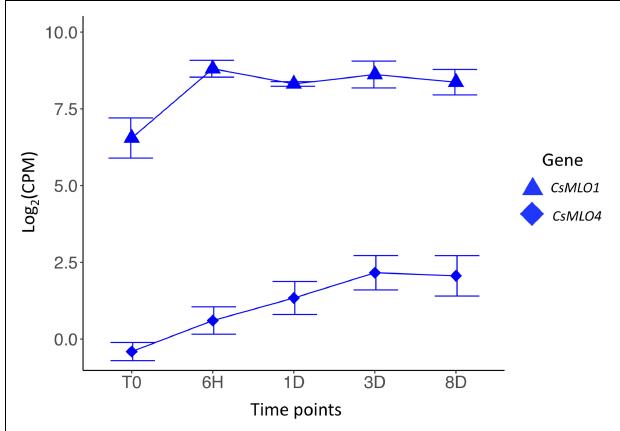
FIGURE 4 | Transcriptomic response of clade V CsMLO genes following inoculations with powdery mildew. Time series analysis of the infection of Cannabis sativa leaves by PM, showing average gene expression for CsMLO1 (blue triangles) and CsMLO4 (blue diamonds). Gene expression is displayed on the y -axis as the average logarithmic value of the Counts Per Million [log 2 (CPM)] at each time point (displayed on the x -axis, n = 3 per time point). Time points: no infection/control (T0), 6 h post-inoculation (6H), 24 h post-inoculation (1D), 3 days post-inoculation (3D), and 8 days post-inoculation (8D). Error bars at each time point represent the standard deviation